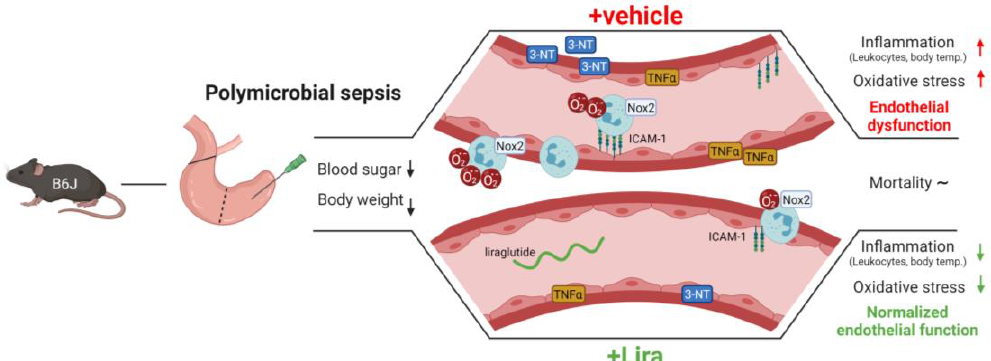
Figure 6. Summary scheme of beneficial cardiovascular effects of the GLP-1 receptor agonist liraglutide on CLP-induced polymicrobial sepsis. CLP-induced mid-grade polymicrobial sepsis led to a reduction in body weight and blood sugar in both vehicle and Lira-treated mice. However, in contrast to the vehicle, Lira protected from sepsis-induced systemic and vascular inflammation and oxidative stress from inflammatory cell-derived Nox2 activity, which translated into a normalized endothelial function yet without a net benefit on mortality. These data demonstrate a new role for GLP-1 receptor agonists like liraglutide in reducing the cardiovascular complications of polymicrobial sepsis based on their antioxidant and anti-inflammatory properties. Created with BioRen- der.com.